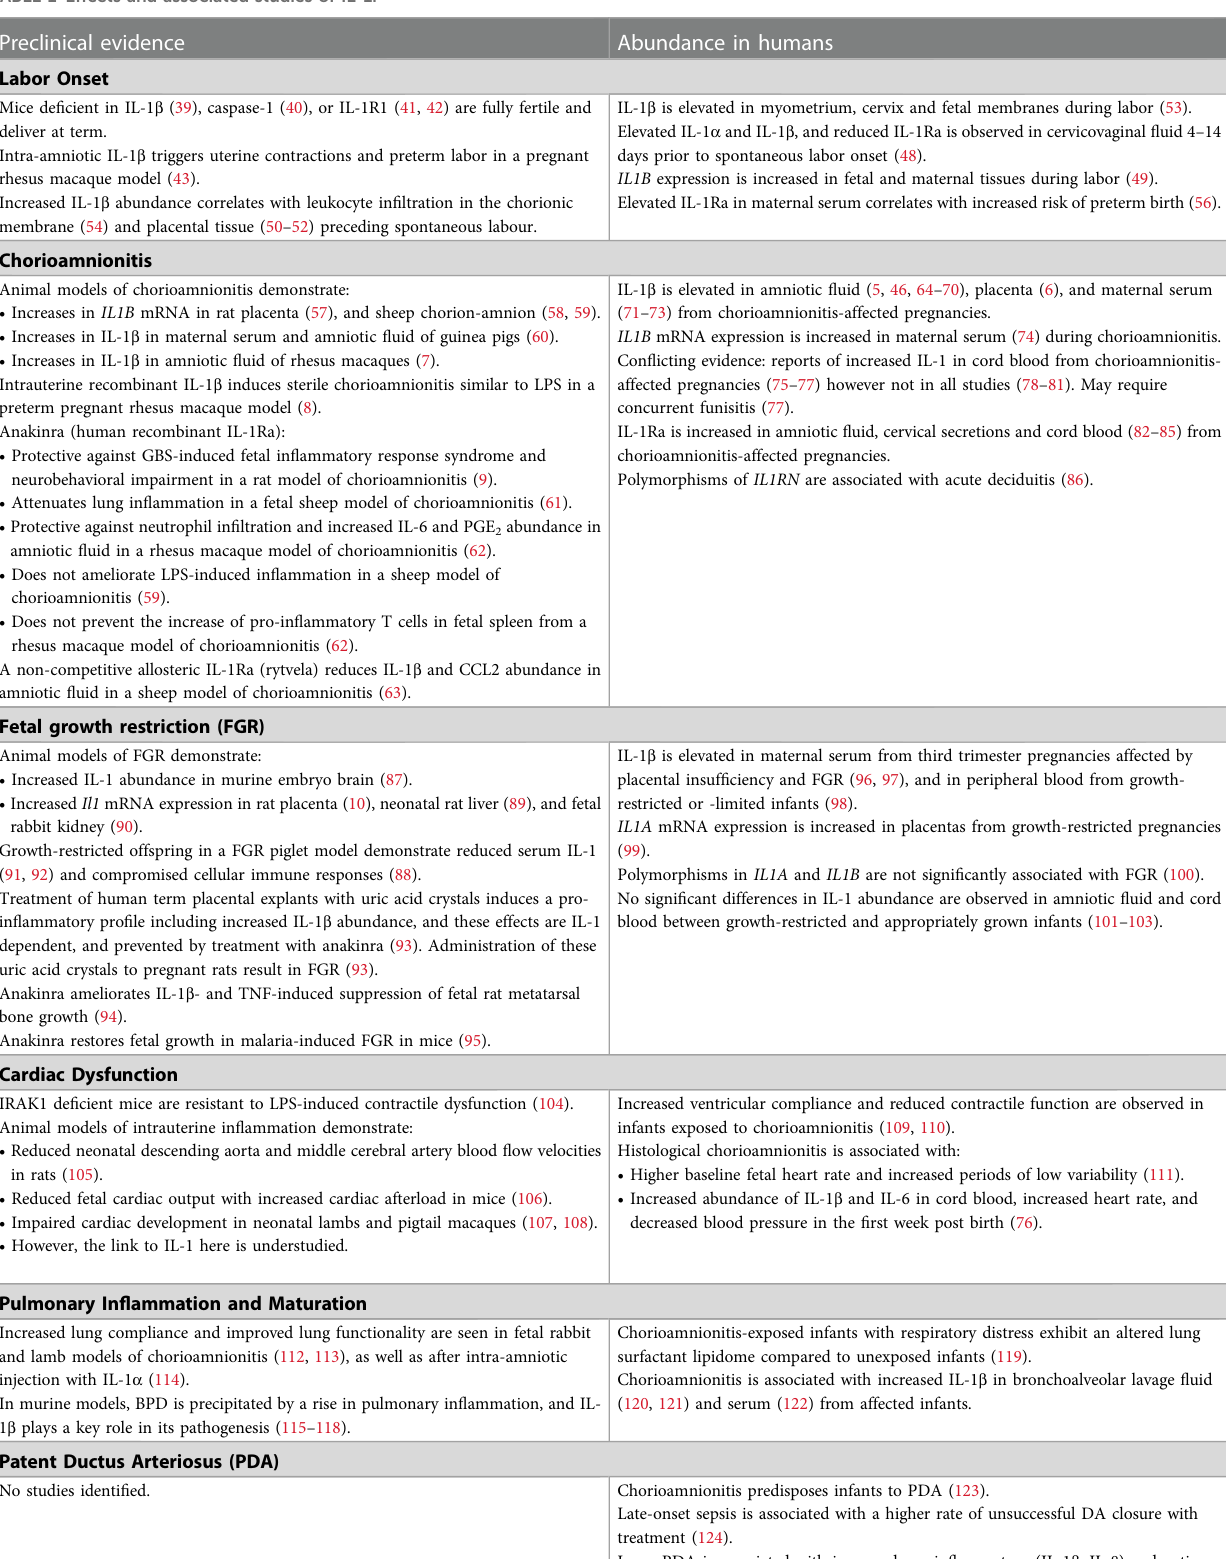
TABLE 1 Effects and associated studies of